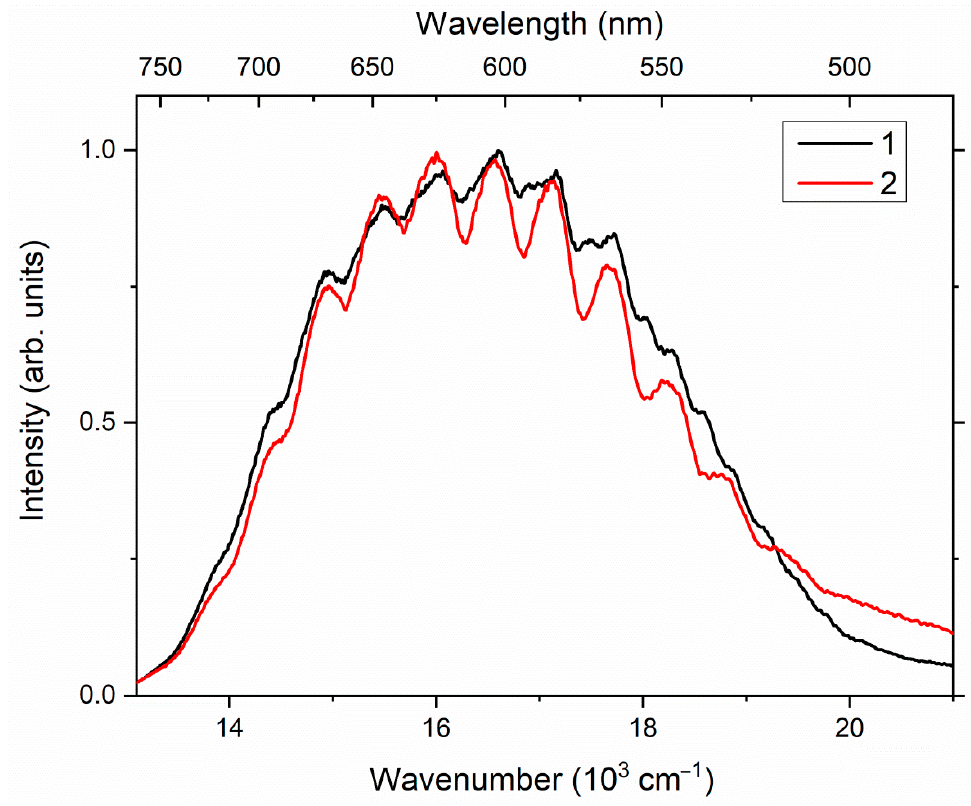
Figure 15. Photoluminescence spectra of afghanite samples from Sar-e Sang (Sample 9, curve 1) and Ladgvardara (Sample 10, curve 2), measured upon excitation with a 405 nm laser at a temperature of 77 K.